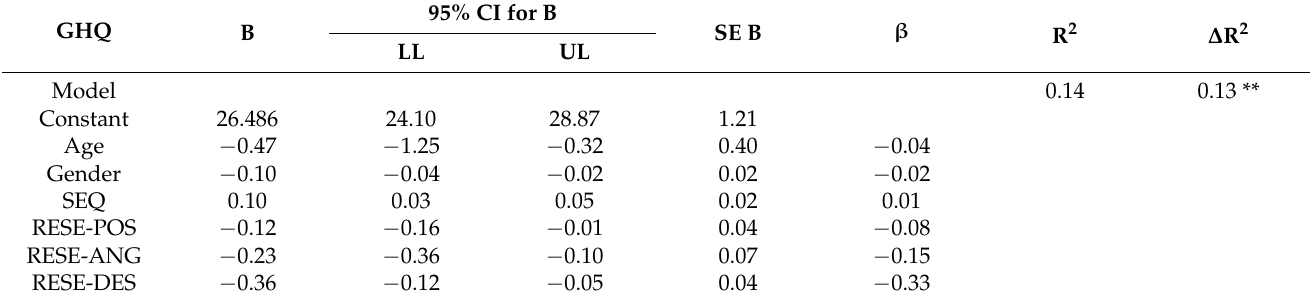
Table 3. Multiple regression results for perceived mental